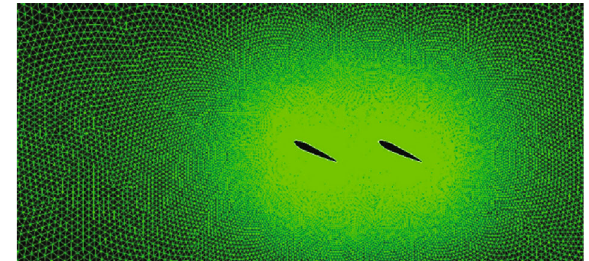
Figure 11: Calculation domain creation and